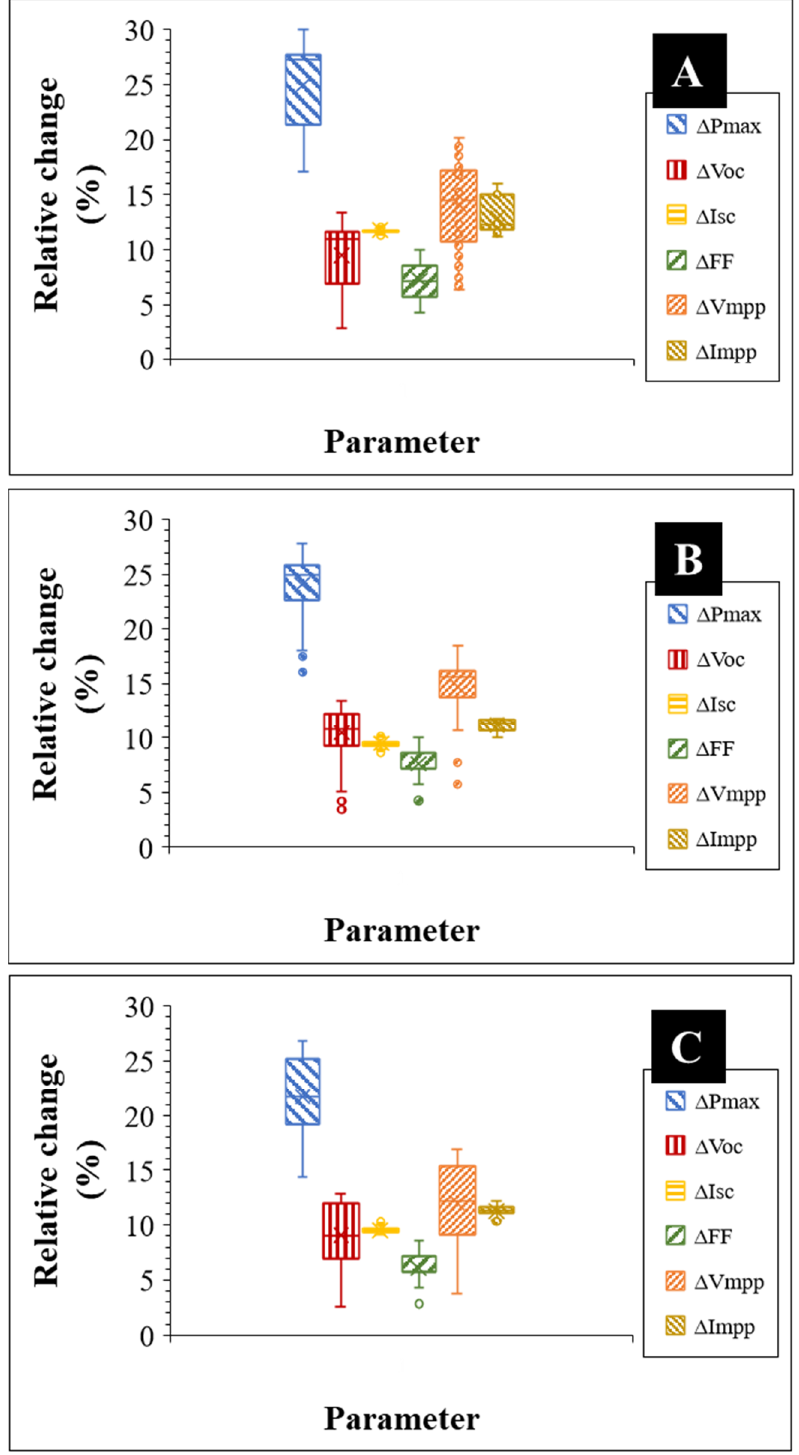
Figure 5. Degradation in the electrical parameters of the old PV panels under STC conditions using Box and Whisker plots. The tips of the boxes show the interquartile ranges. The internal lines show the median and the x -marks show mean. ∆ is the difference between data sheet (2000) and measured (2021) values. Measurements were done under 960–1060 W/m 2 in-plane irradiance conditions. The position of the box indicates the percentage degradation, and the dots show the outliers. The degree of deviation of the electrical parameter from the mean value is indicated by the length of the box. The degradation in the electrical parameters of the 3